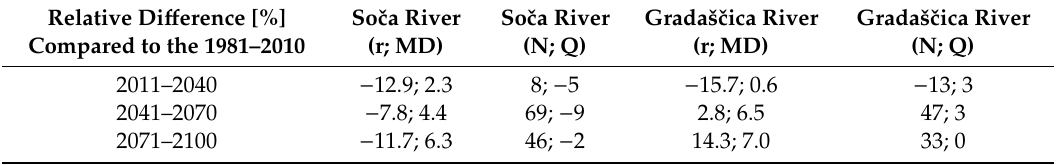
Table 2. Relative di ff erences between median strength of seasonality (r), mean direction of the flood date (MD), number (N), and magnitudes (Q) of rain-on-snow (ROS) floods for di ff erent periods compared to the baseline period. Median values were calculated based on the results of all five investigated